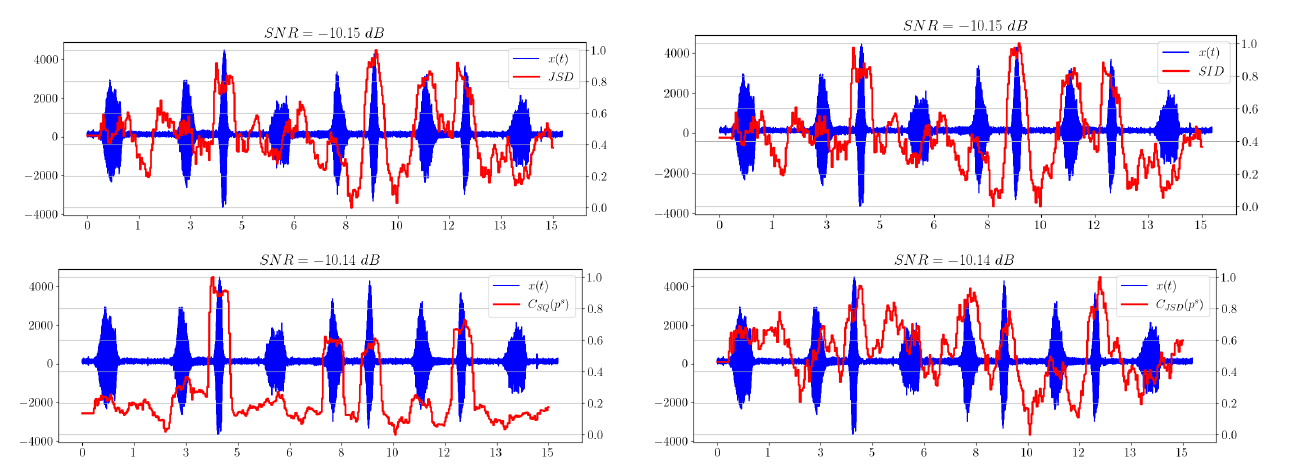
Figure 6. Information divergence plots based on spectral distribution.